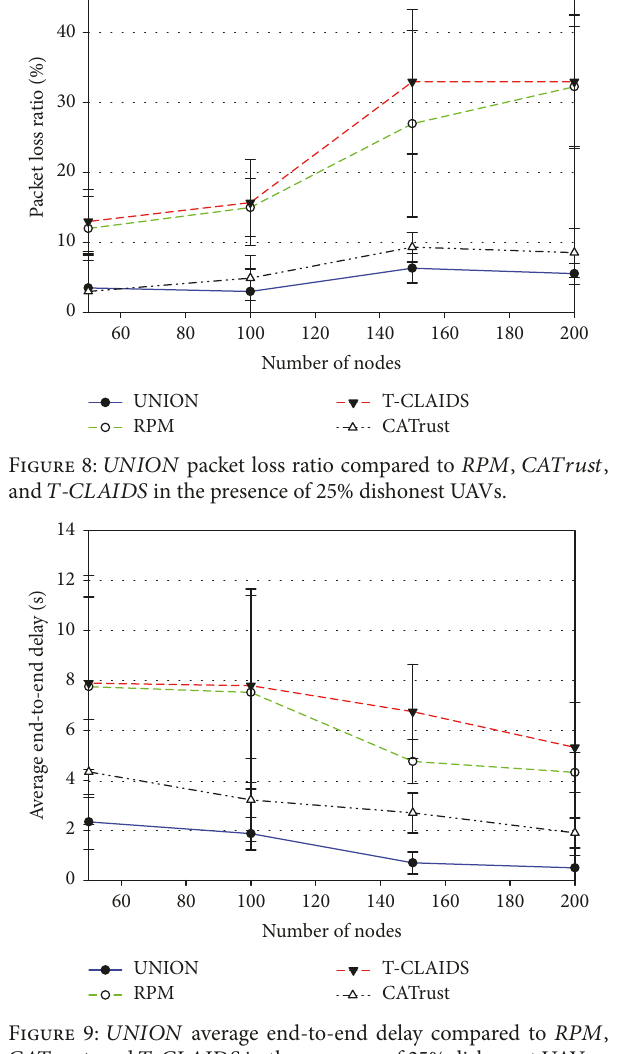
Figure 9: 𝑈𝑁𝐼𝑂𝑁 average end-to-end delay compared to 𝑅𝑃𝑀 , 𝐶𝐴𝑇𝑟𝑢𝑠𝑡 , and 𝑇 - 𝐶𝐿𝐴𝐼𝐷𝑆 in the presence of 25% dishonest UAVs.